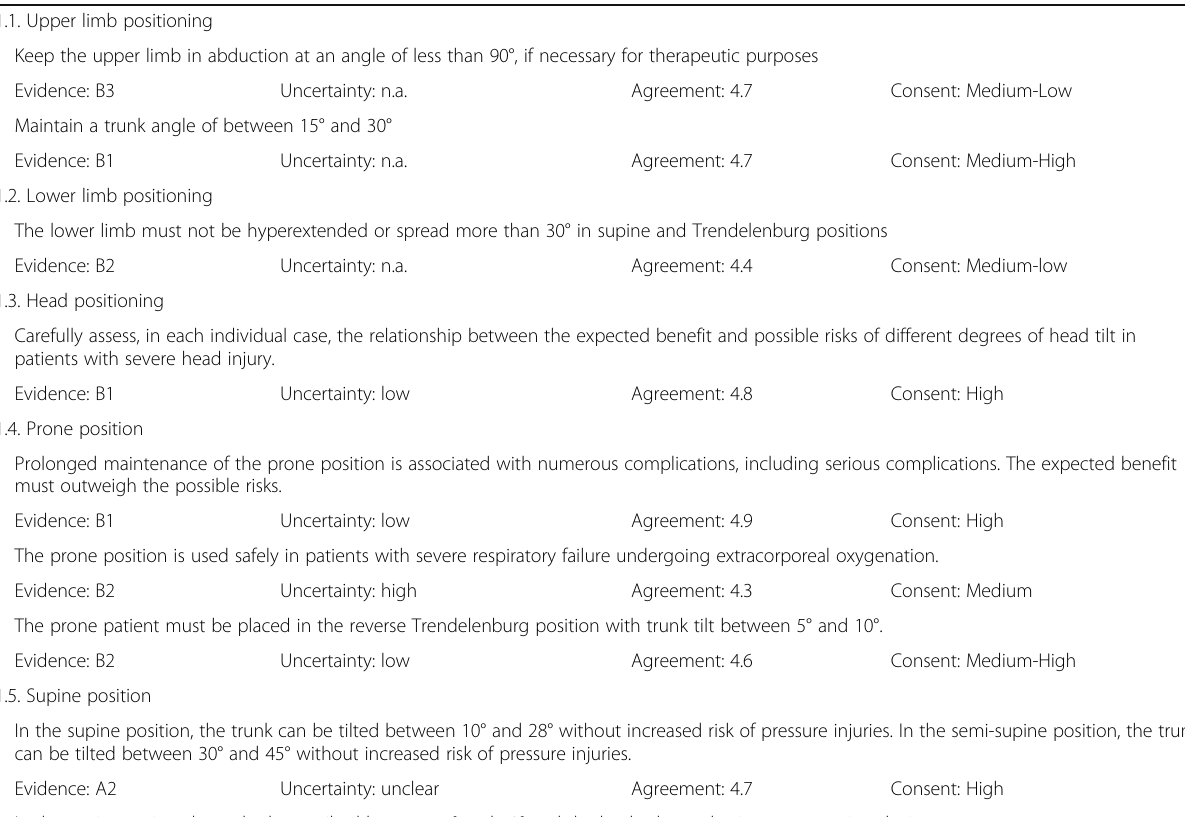
Table 3 Good practice summary